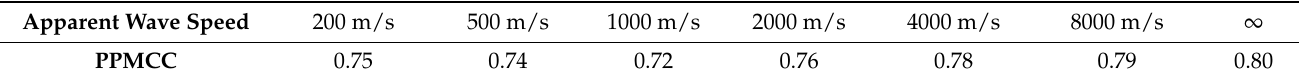
Table 6. The moment when the maximum stress occurs at points A and D.